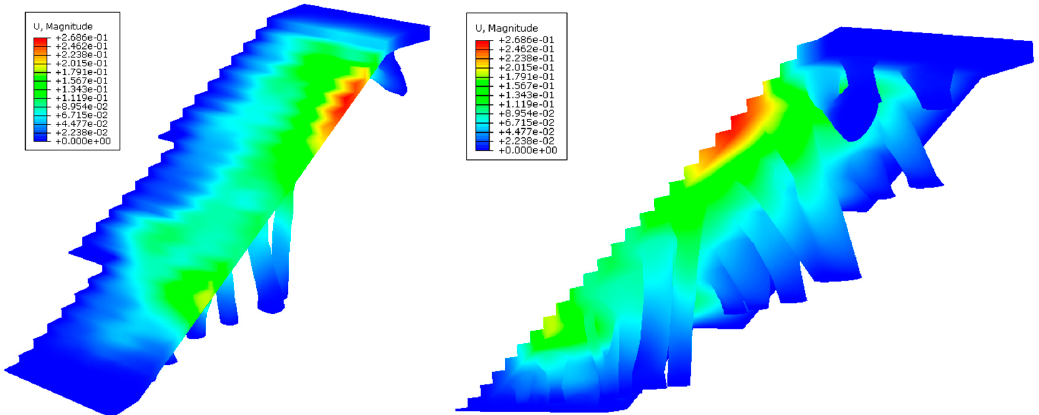
Figure 26. Field of the von Mises stress (MPa) obtained in the mechanical simulations: the BIM building element E 2 indicated in two perspectives in the left and right pictures.